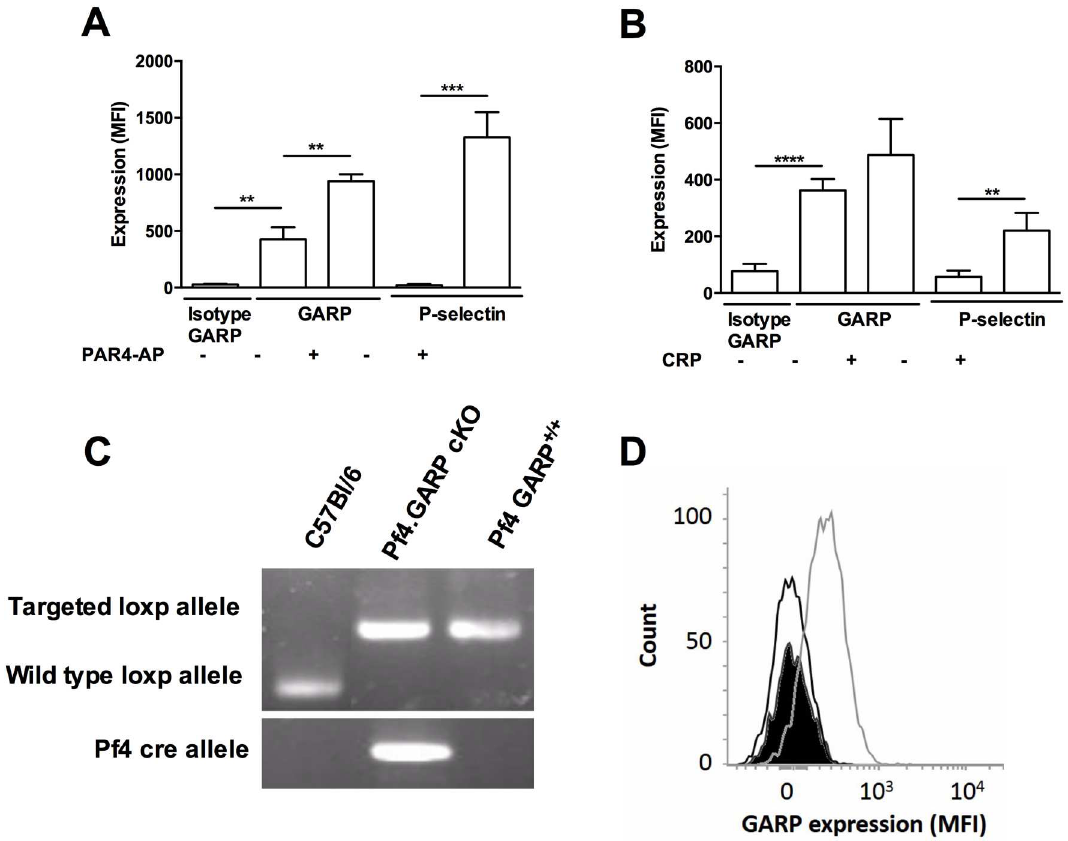
Fig 1. Generation of platelet specific GARP knockout mice. GARP and P-selectin expressionon 700 μ M PAR4-AP ( A ) or 20 μ g/mL CRP ( B ) activated murineplatelets. Mean fluorescence intensity (MFI) of anti-GARP-APC and anti-P-selectin CD62P-PE are shown. (C) Genotypic analysisof genomicDNA from control C57BL/6, littermates and platelet specific cKO mice. Loxp is 181 bp (fl/fl); wt alleleis 111 bp, Cre 250 bp. ( D ) Phenotypic characterization of littermates and cKO mice using flow cytometry. Platelets were labeledwith anti-CD41-FITC and anti-GARP-APC and a histogramwas made basedon APC intensity of CD41+ cells: isotype control (black line), littermates (grey line) and cKO